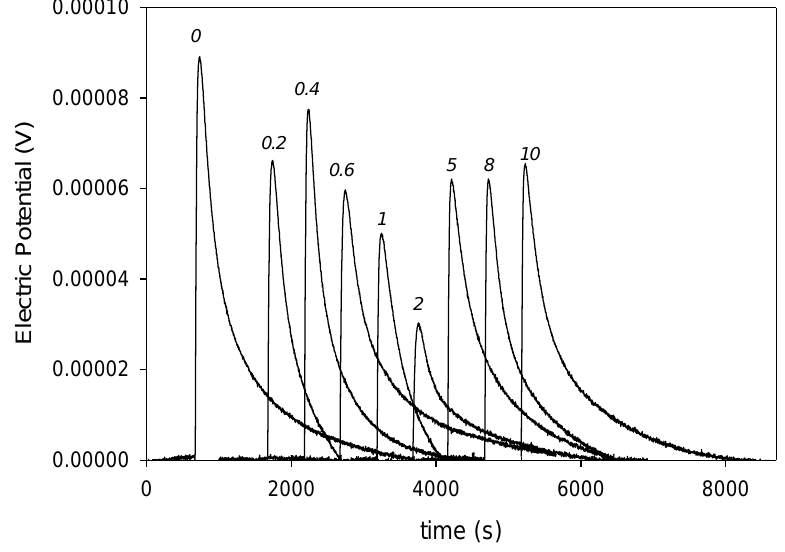
Figure 7. Potentiometric curves obtained during the immersion calorimetry for the activated carbon sample GNA in solutions of phenol; the numbers over peaks correspond to the concentration of phenol at the beginning of the calorimetry immersion in mmol∙L −1 .